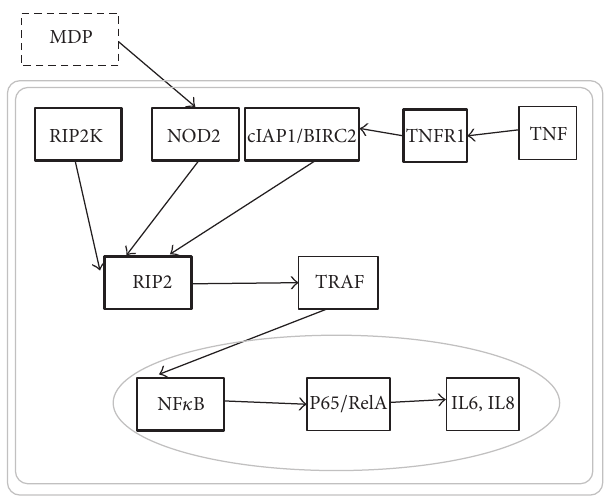
Figure 3: Significantly differentially regulated genes in NOD2 Pathway. Genes significantly upregulated in the RNAseq screen (heavily outlined boxes). Post hoc analysis found notable differences in expression level in RIPK2 nine isoforms (five with average 3.3- fold increase, average 𝑝 value 0.053, three isoforms ns, and one with 1.5-foldchange), ERK/MAPK14 isoforms(onewith3.8-foldincrease, 𝑝 < 0.002 , three ns), JNK/MAPK8 three isoforms (fold difference 4.1, 𝑝 < 0.009 , two other isoforms ns), and NF 𝜅 B (fold difference 4.08, 𝑝 < 0.04 ). The following showed no significant difference in expression level: ERBIN , iKKB , CASP8, TAK1 , TRAF6 , TRIP6 , SGT1 , and CARD6 .